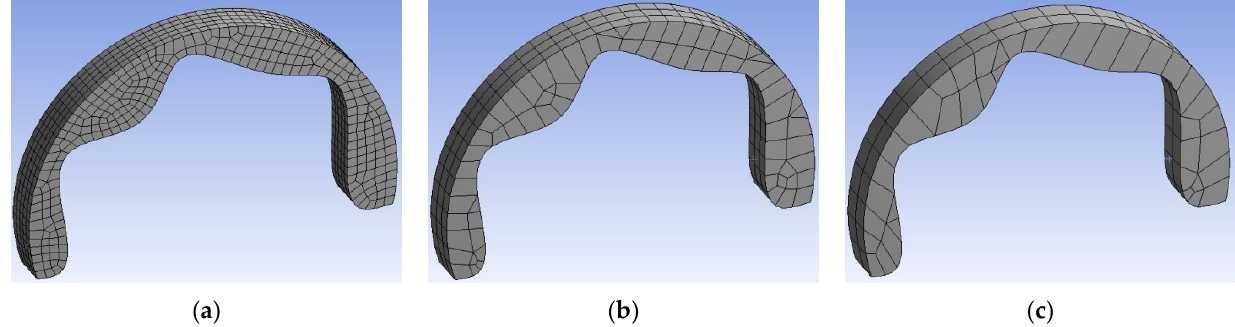
Figure 2. Images of meshed solid models with different numbers of nodes and elements: ( a ) mesh model-1, ( b ) mesh model-2, and ( c ) mesh model-3. Table 2. FE solution information against different mesh models.